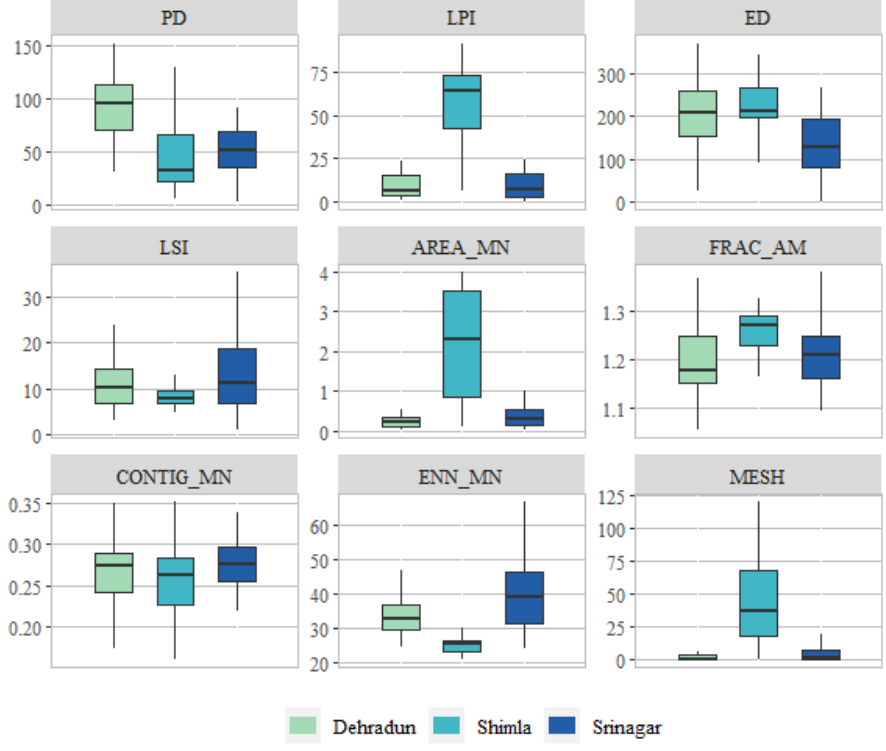
Figure 6. Boxplot showing the variation in landscape metrics among the three cities.